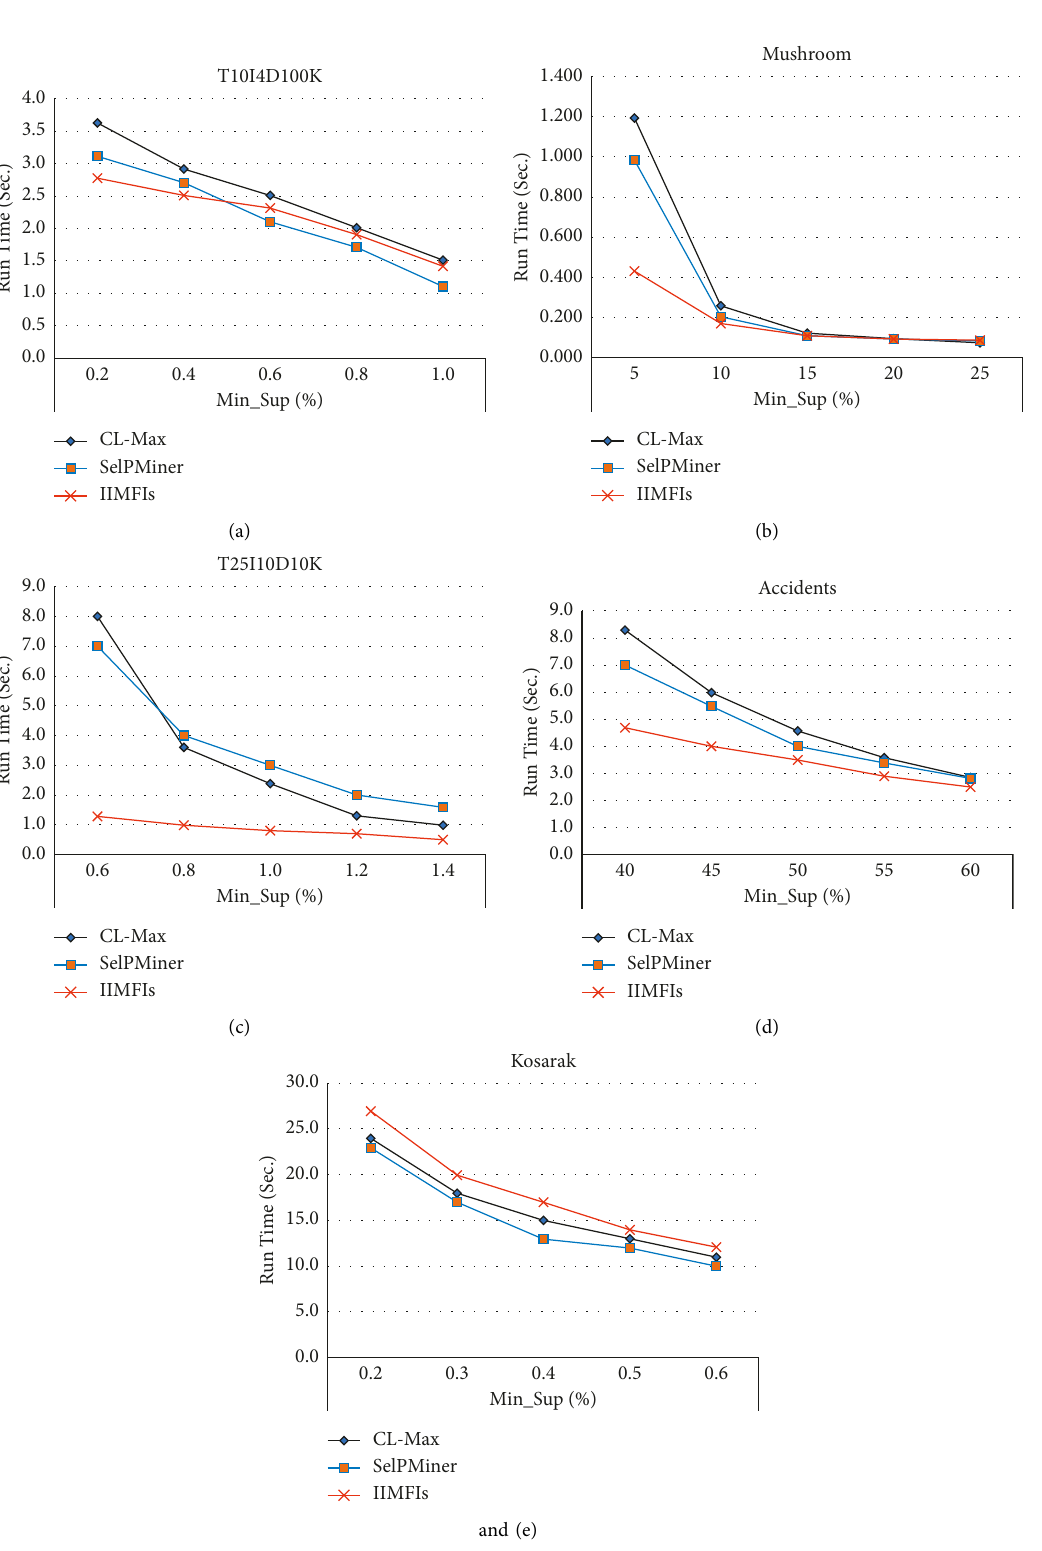
Figure 7: Comparing the runtime (Sec.) between CL-Max, SelPMiner, IIMFIs algorithms on the datasets at static state. (a) T10I4D100K, (b) Mushroom, (c) T25I100D10K, (d) Accidents, and (e)